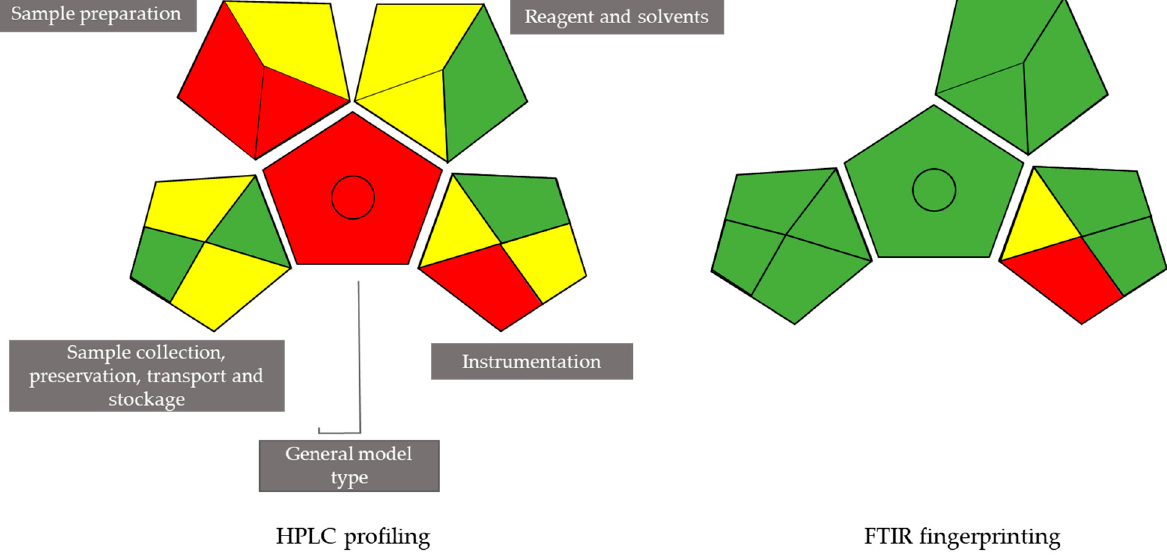
Figure 12. Green Analytical Procedure Index (GAPI) pictogram for ecological impact evaluation of analytical methods used in this study.